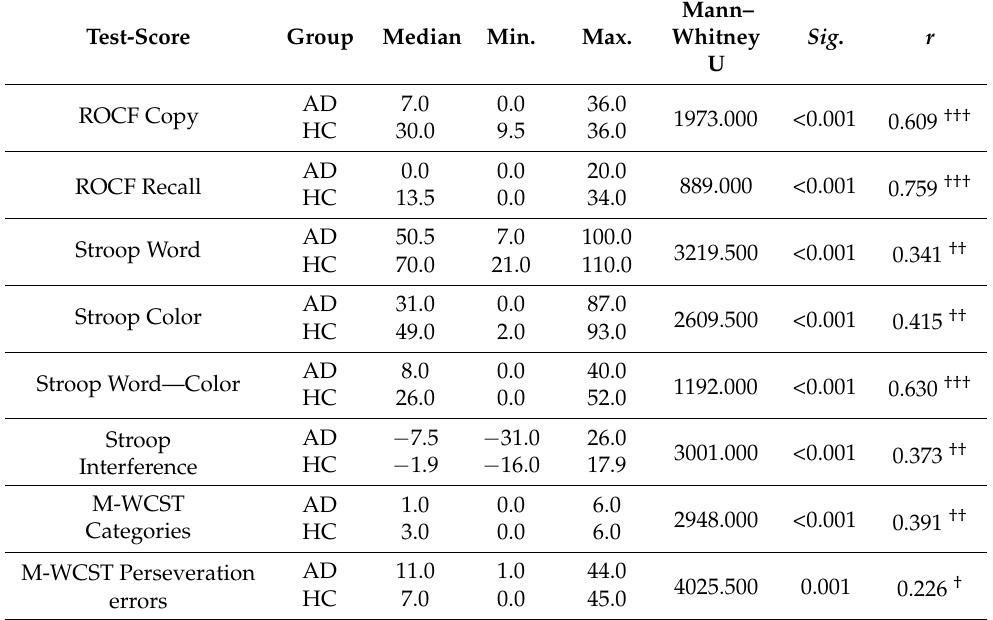
Table 2. Comparison between groups on neuropsychological test